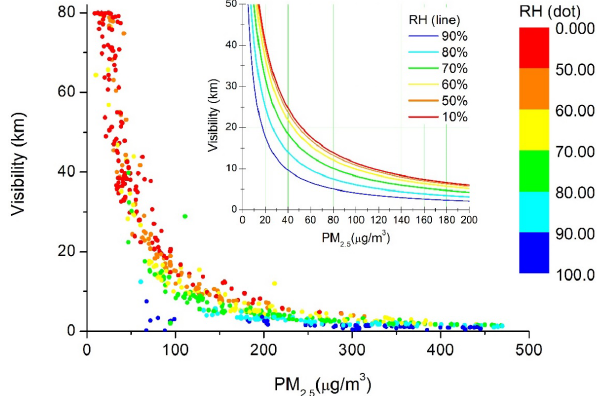
Figure 15. Variation of visibility at different RH values and differ- ent concentrations of PM 2 . 5 , observed (dots) and simulated